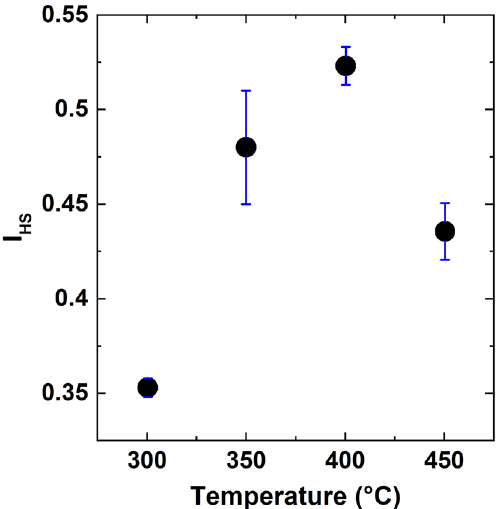
Figure 6. The dependence of the Hopkins–Skellam index ( I HS ) on the deposition